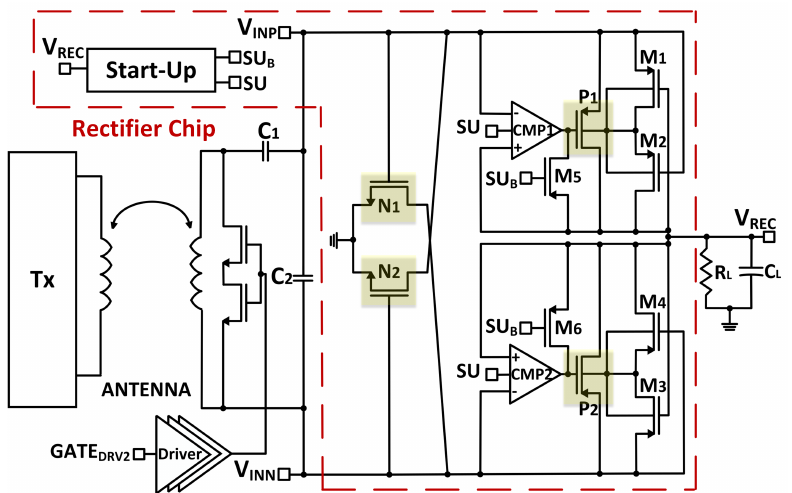
Figure 7. Transistor-level schematic of active